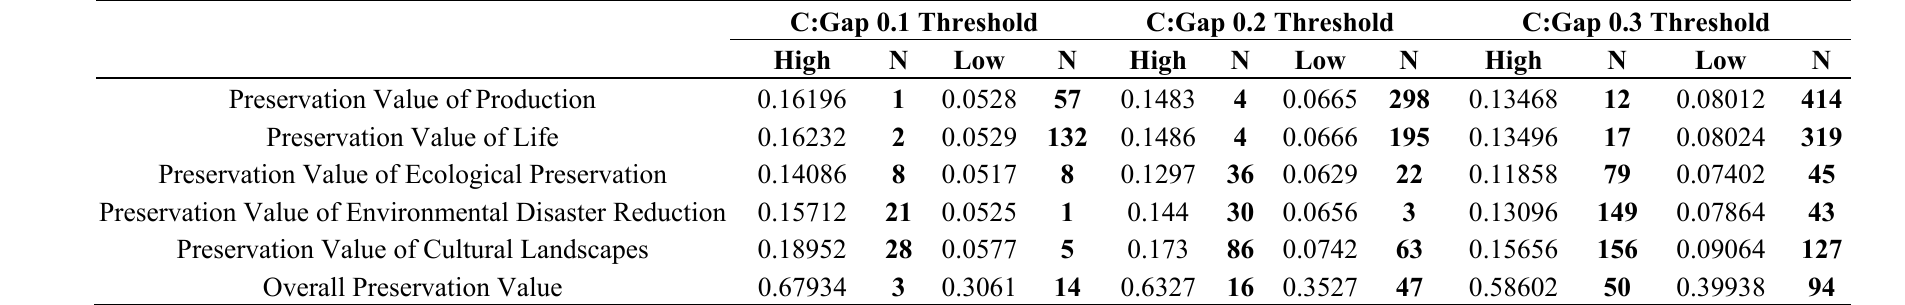
Table 3. Farm ponds preservation level evaluation.